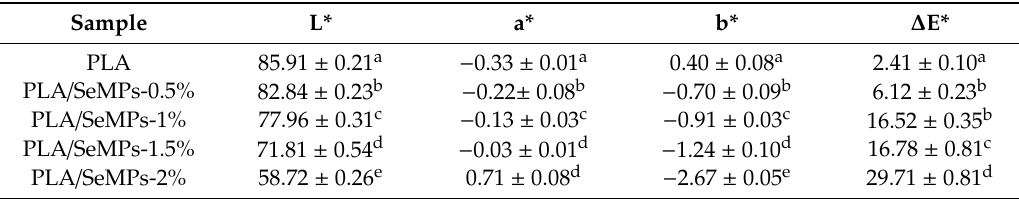
Table 3. Optical properties (L*, a*, b*, ∆ E*) of di ff erent composite